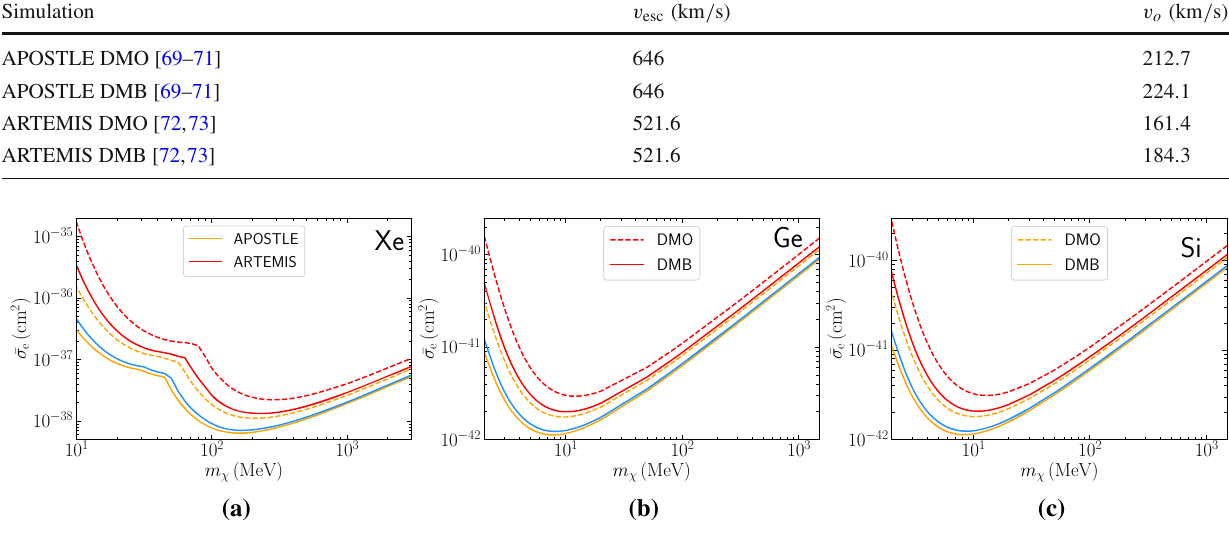
Fig. 2 Variation in the SHM for the APOSTLE and ARTEMIS simu- lations for F DM = 1. The light blue solid lines denote the fiducial SHM exclusion limit. The dashed lines corresponds to upper limit on DM- electroncrosswhenSHMisfittedwithDMonlysimulation(denotedby